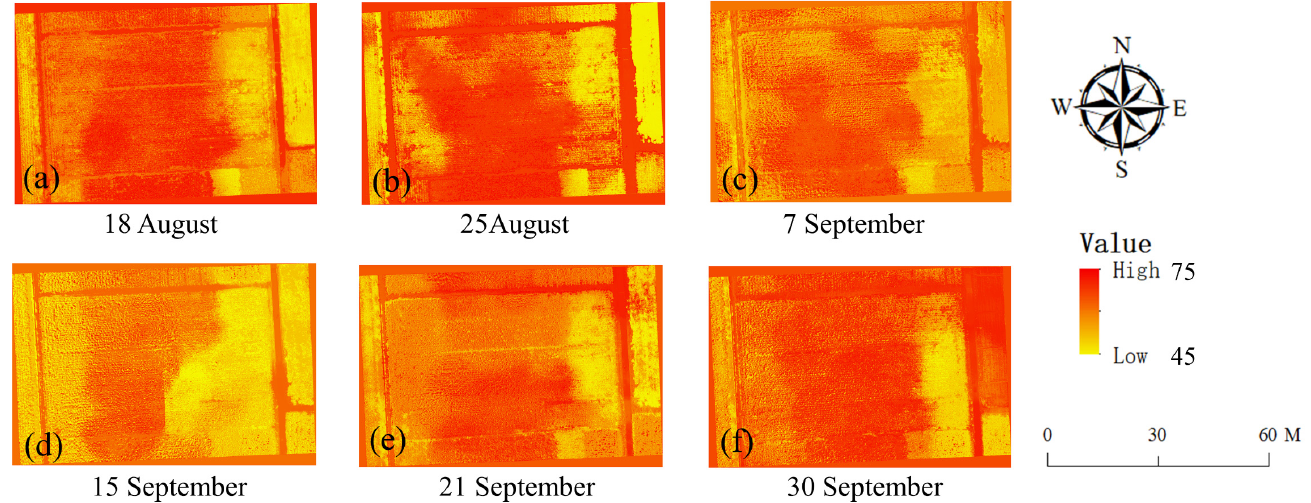
Figure 9. Predicted SPAD values using the support vector machine (SVM) at different growth stages of maize. Note: the dates under images are the date of data acquisition. ( a – f ) each represented the predicted SPAD values for 18 August, 25 August, 7 September, 15 September, 21 September, 30 September, respectively.